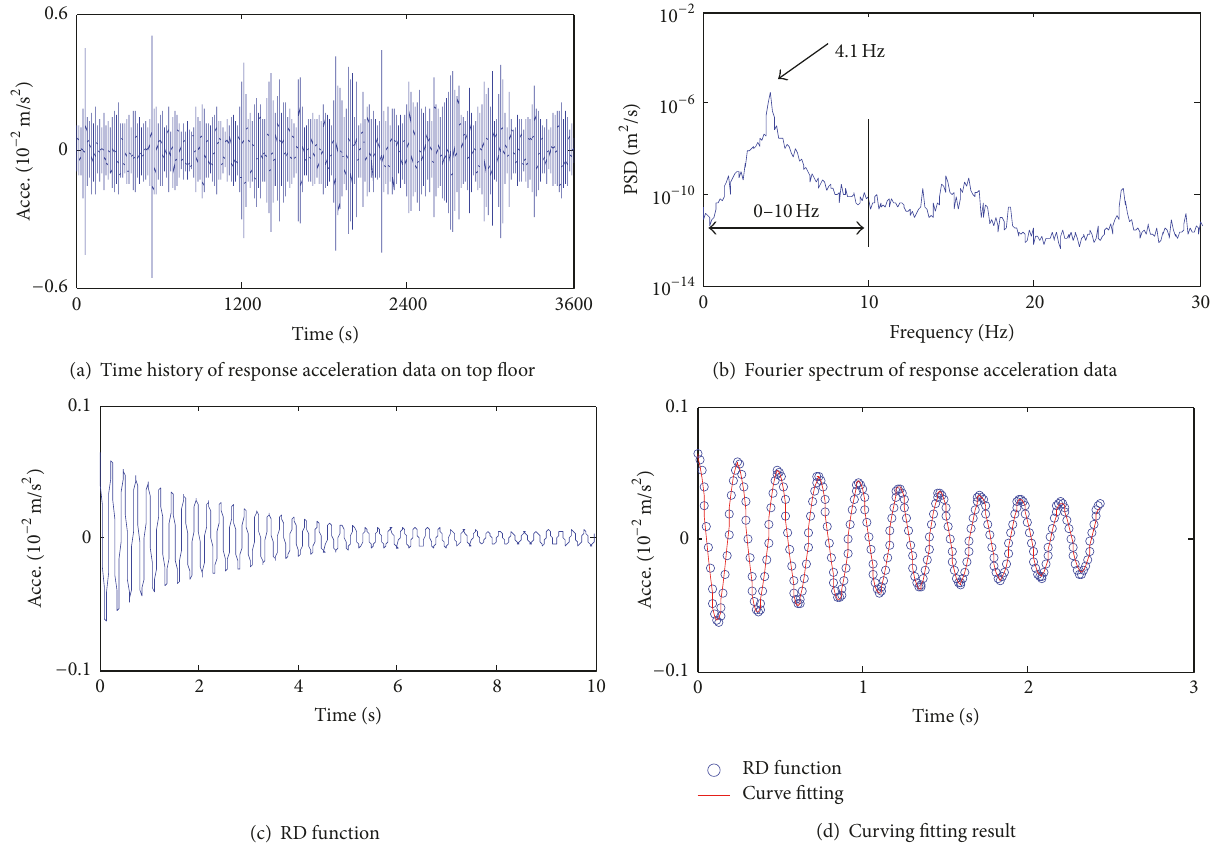
Figure 8: Data processing procedure of ambient vibration test data of Case 3